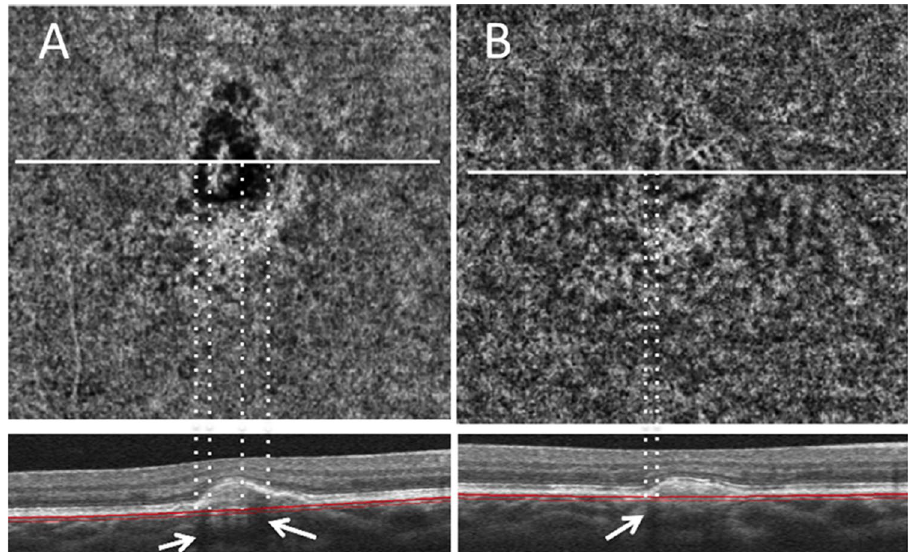
Figure 2. Optical coherence tomography angiography images of the choriocapillaris layer with horizontal cross-sections from a 36-year-old man with myopic choroidal neovascularization (CNV). ( A ) The patient had previously been treated with intravitreal ranibizumab (IVR) injection. Eight months after the initial IVR injection, the CNV complex was re-enlarged, and a choriocapillaris flow deficit (CFD) was observed around CNV. The CFD nearly corresponds to the dark area on a B-scan OCT image (arrows). A second injection of IVR was administered. ( B ) One year after the second IVR injection, the CNV complex and CFD remained, but the CFD decreased in size.